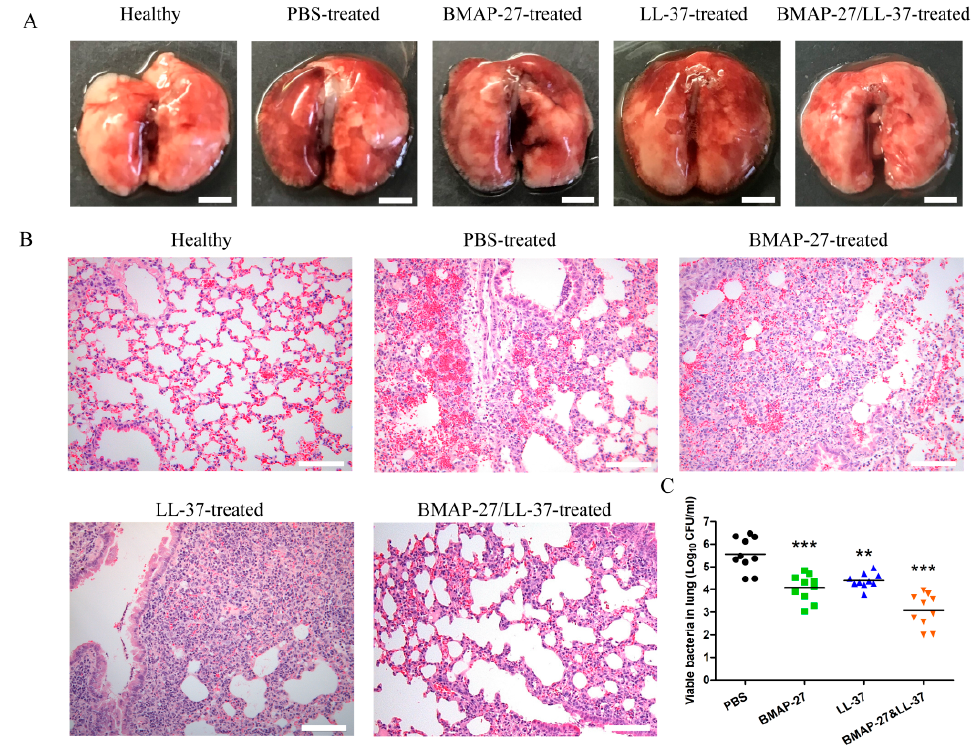
Figure 9. Combined therapy of BMAP-27 and LL-37 reduces the bacterial burden and organ injury in the mice after P. aeruginosa infection. Mice were intratracheally challenged with 3 × 10 6 CFU of P. aeruginosa and then administered a single-dose treatment of BMAP-27, LL-37, the combination of BMAP-27 and LL-37, or PBS. At 24 h posttreatment, samples were harvested from the ( A ) lungs (scale bars = 4 mm) for ( B ) histopathological hematoxylin-eosin staining (scale bars = 100 μ m) and ( C ) bacterial quantification. Values represent mean ± SD from 10 mice, ** P < 0.01, *** P < 0.001.